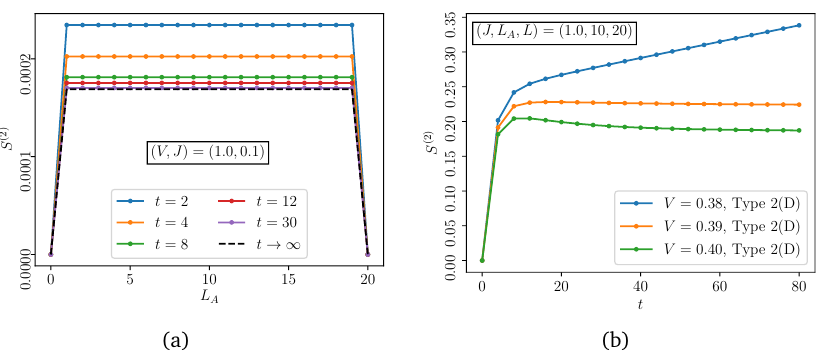
Figure 7: (a) The result for S ( 2 ) vs L saddle around the transition